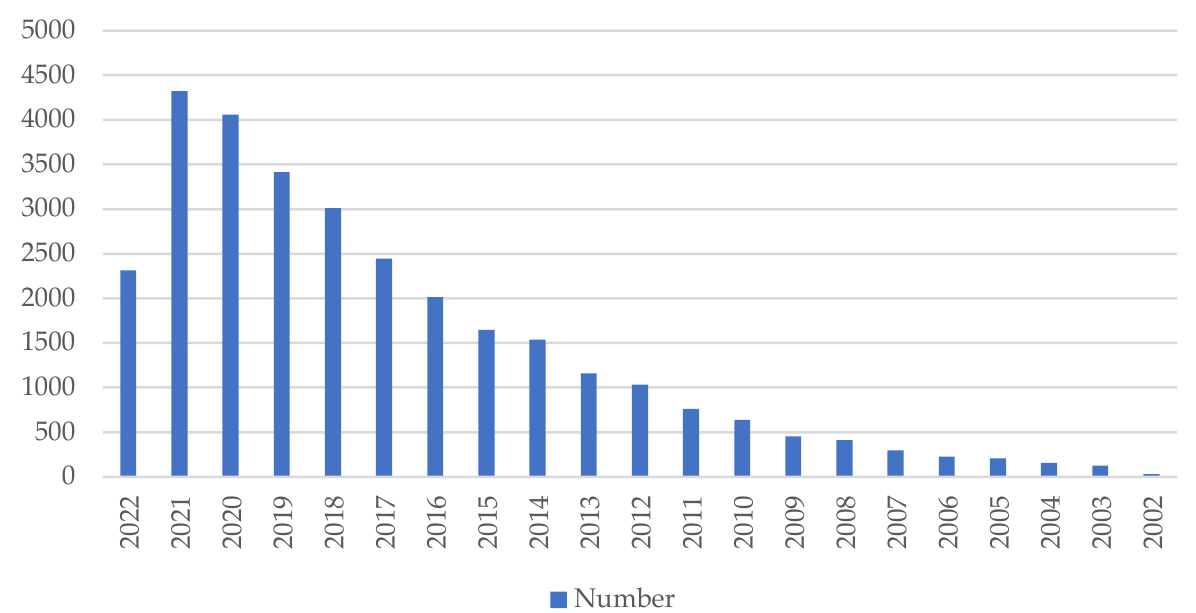
Figure 4. Number of publications on building energy consumption.